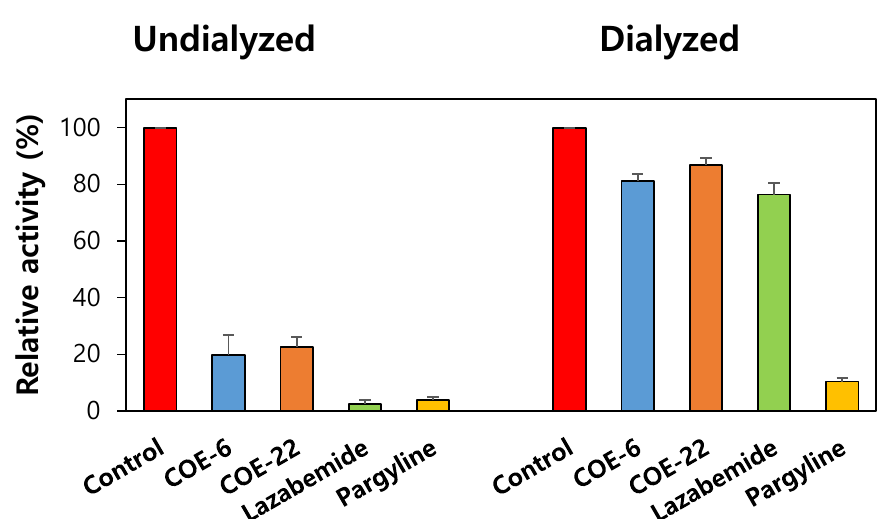
Figure 4. Recoveries of inhibitions of MAO-B by COE-6 and COE-22 as determined by dialysis. Molecules 2020 , 25 , x FOR PEER REVIEW